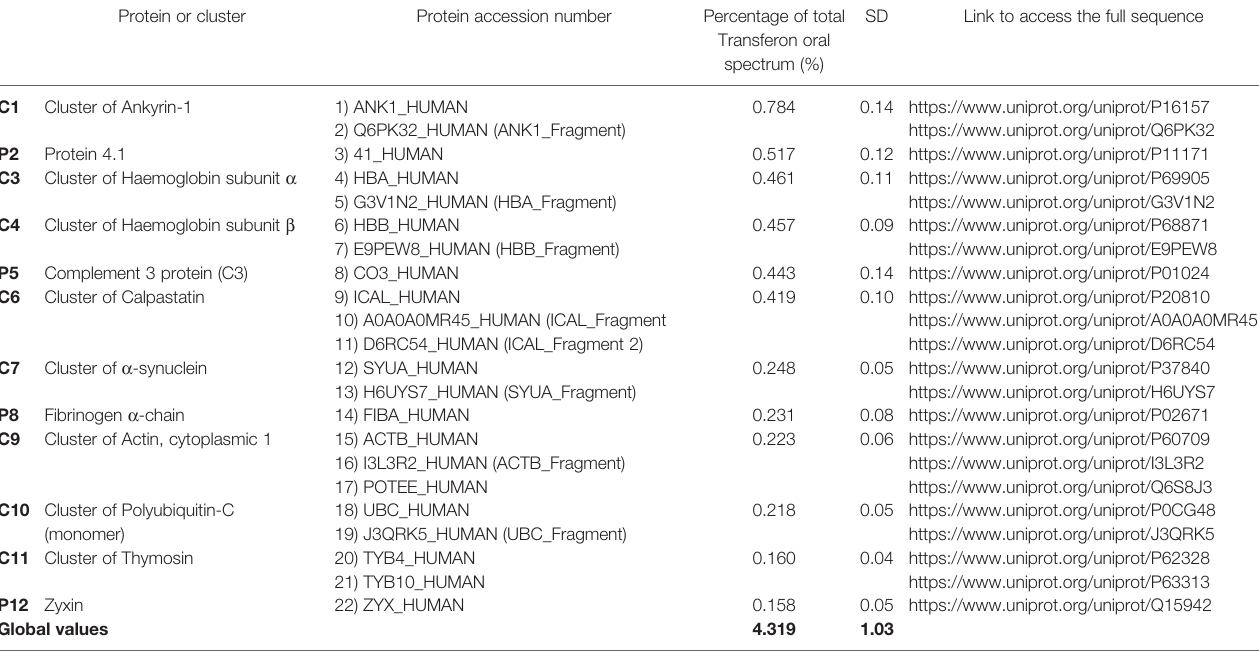
TABLE 1 | Main proteins than provide of peptide components to Transferon. Protein or cluster Protein accession number